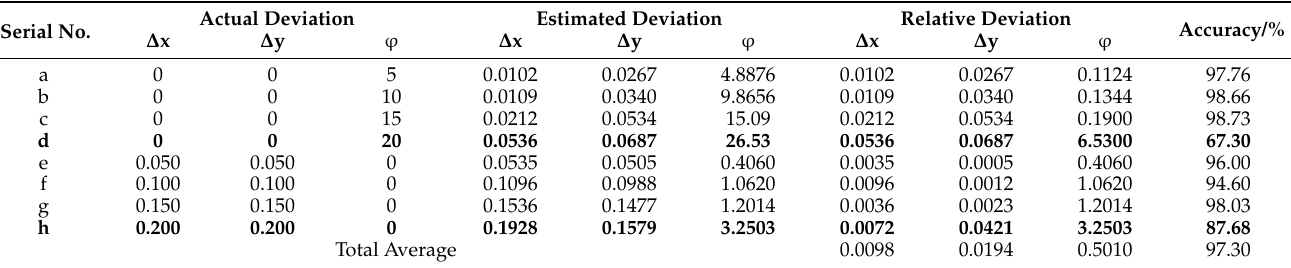
Figure 11. Point cloud processing results of 5° deflection angle. ( a ) Scene point cloud. ( b ) Initial relative position. ( c ) Target point cloud. ( d ) Key points of the target point cloud. ( e ) Coarse registration. ( f ) Accurate registration. Table 2. Experimental results of the ground